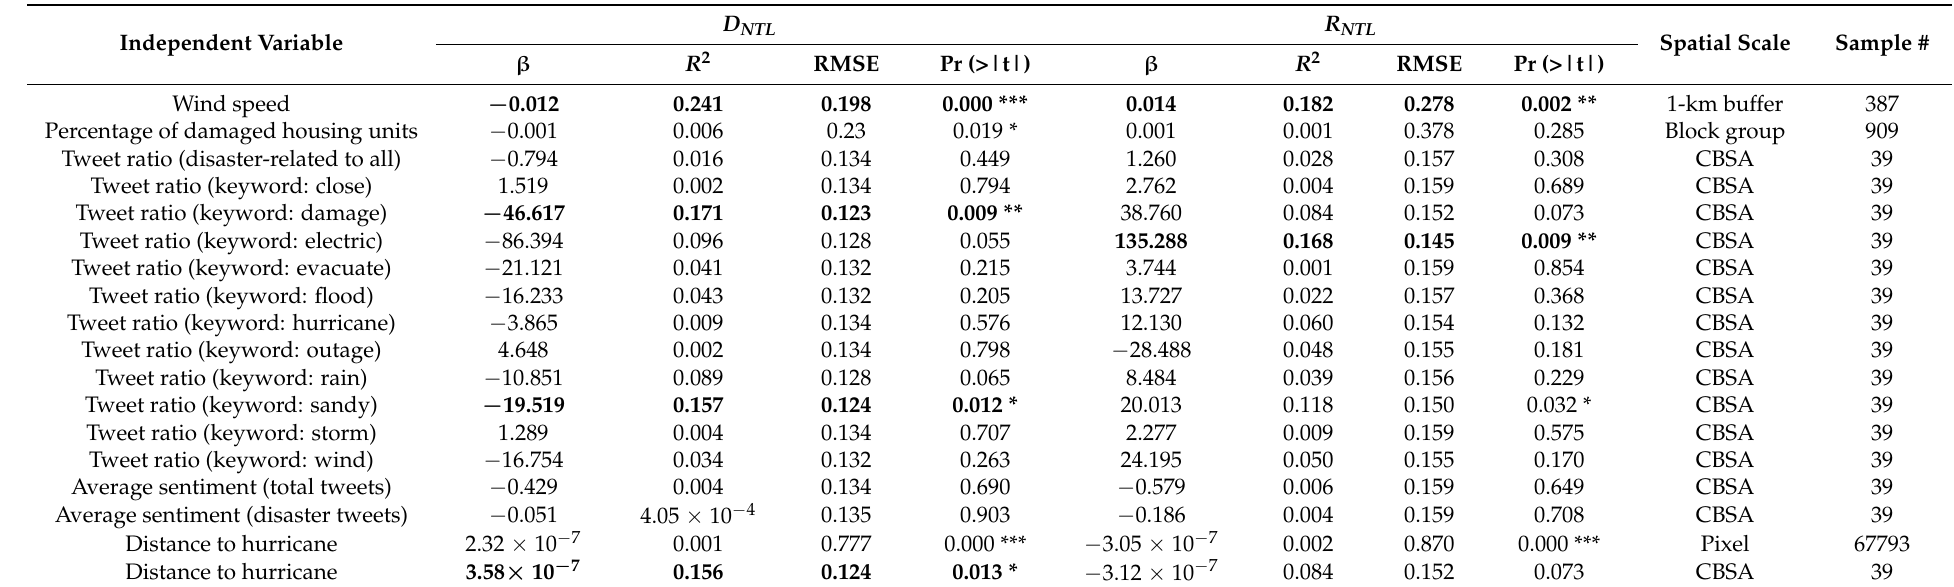
Table 2. Relationship between the reduction in NTL radiance and auxiliary damage